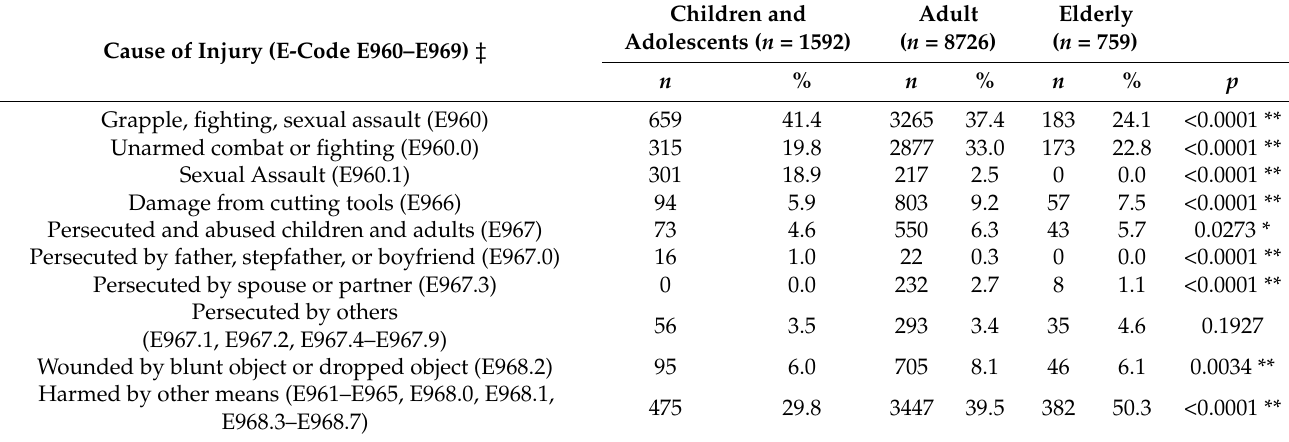
Table 1. Causes of injury to victims of violence in different